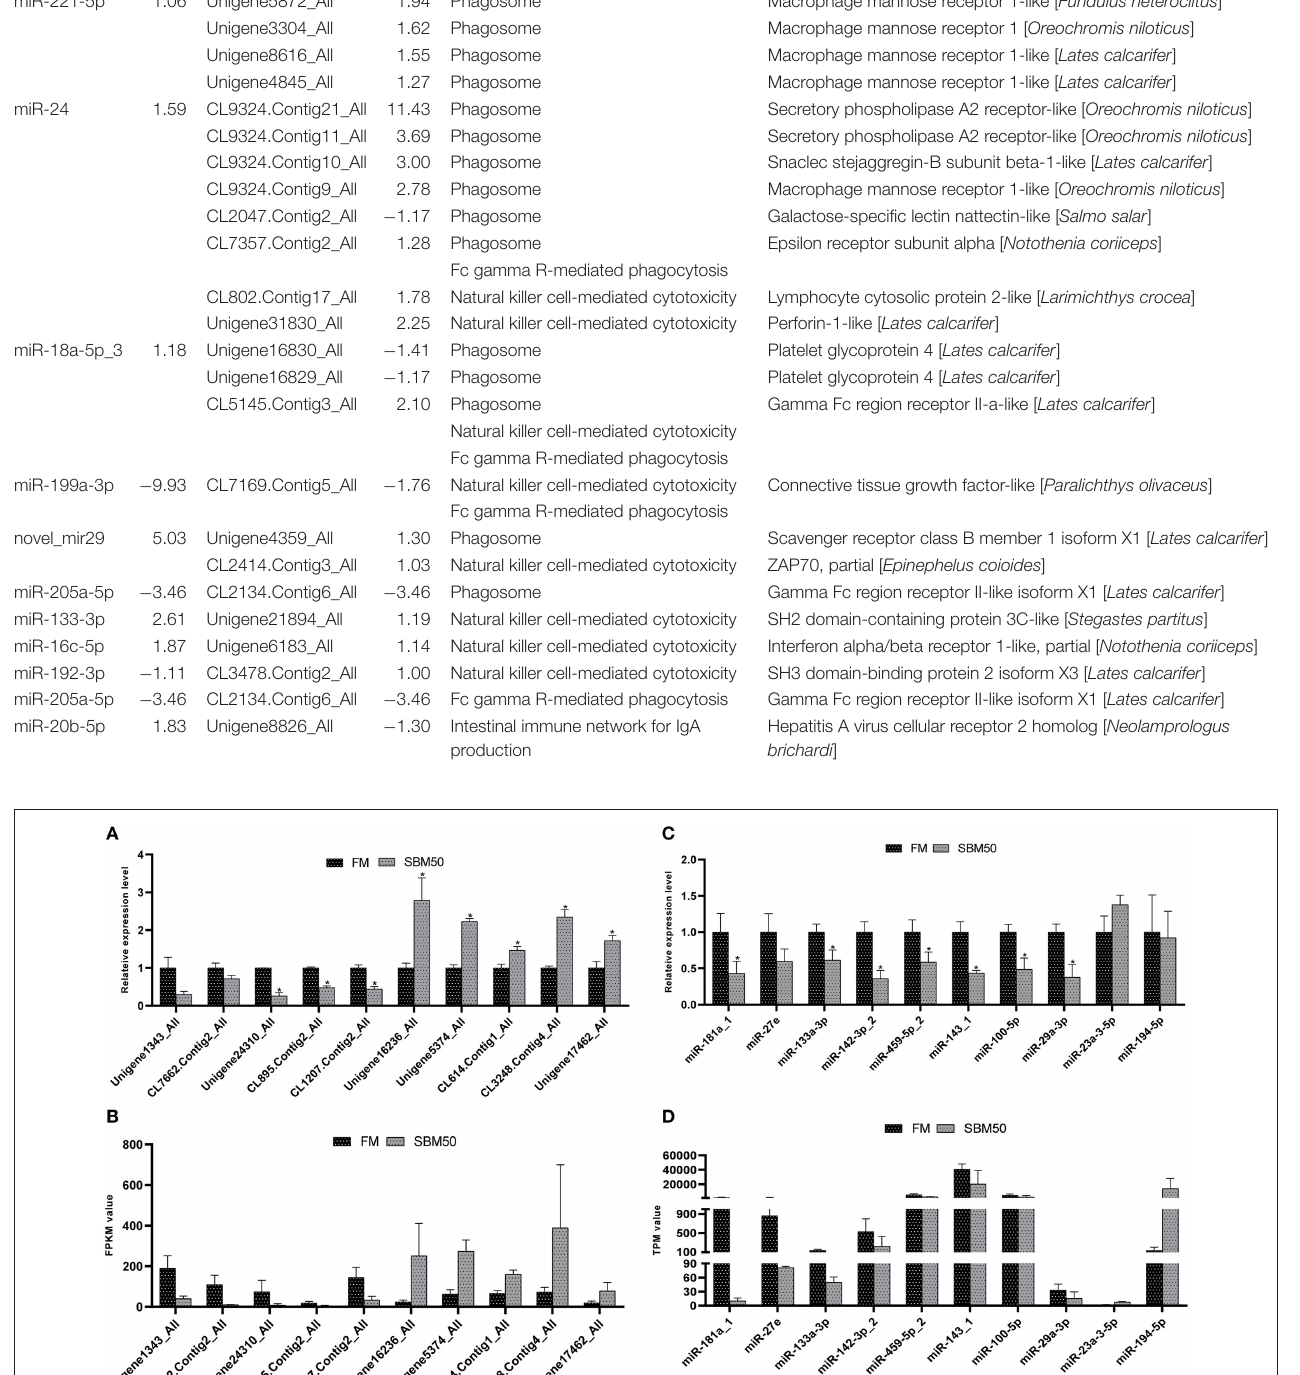
Frontiers in Immunology |